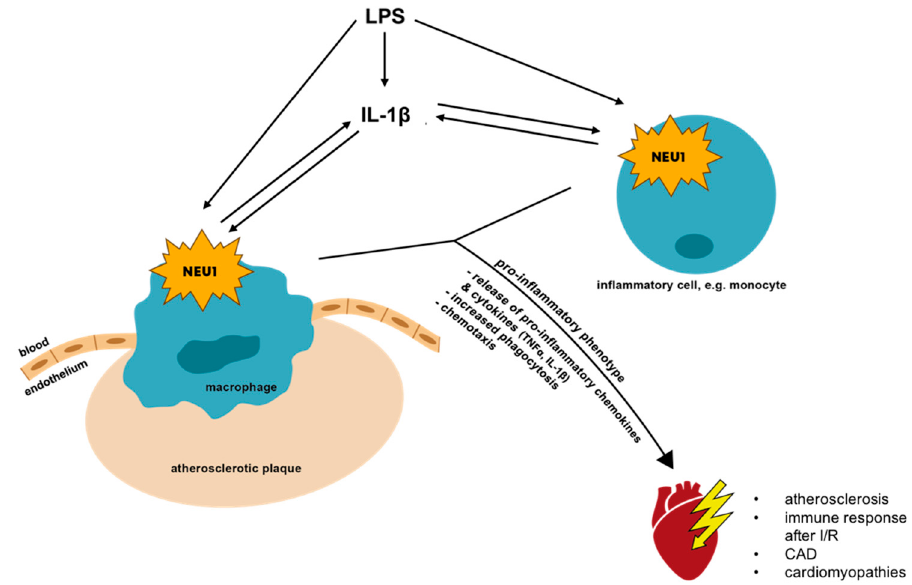
Figure 2. Scheme illustrating the consequences of an altered NEU1 expression in immune cells. NEU1, highly expressed in human macrophages of human atherosclerotic plaques, is upregulated in monocytes and macrophages by LPS and IL-1 β , both in turn, inducing the expression of pro-inflammatory cytokine TNF α . Further, there seems to be a positive feedback loop between IL-1 β and NEU1, promoting inflammation. The upregulation of NEU1 leads to an enhanced pro-inflammatory phenotype of immune cells concomitant with an increased release of pro-inflammatory chemo- and cytokines, increased phagocytosis and chemotaxis. The pro-inflammatory phenotype contributes to cardiac disease onset and progression. Figure adapted from Sieve et al., 2018. Abbreviations: IL-1 β , interleukin-1 β ; NEU1, neuraminidase 1; LPS, lipopolysaccharide; TNF α , tumour necrosis factor α .